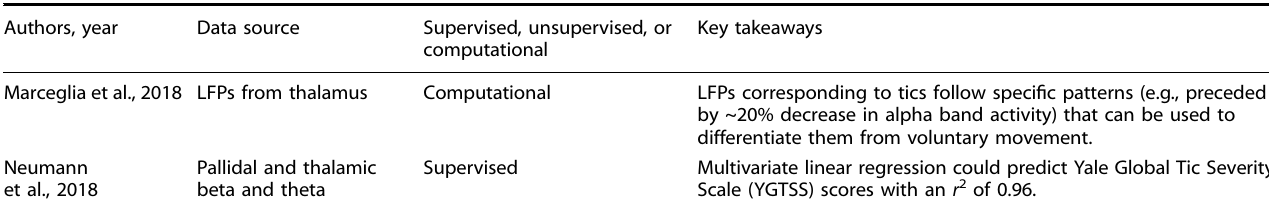
Table 5. Studies assessing the use of ML to develop closed-loop systems for Tourette ’ s.